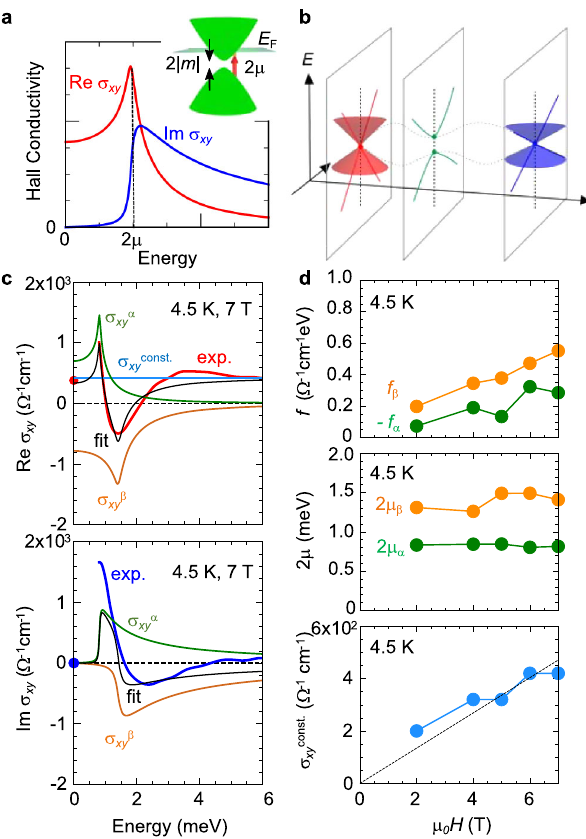
Fig. 3 Two-band model analysis for terahertz resonances. a The AH conductivity spectra calculated from the two-band model. (inset) The schematic illustration of the single anti-crossing point. b Schematic illustration of the electronic structure considered in the present analysis. c The red (Re σ xy ) and blue (Im σ xy ) curves show experimental results and the black curves represent the fi tting curves at 4.5 K and 7 T. The σ xy α (green) and σ xy β (orange) are optical Hall conductivity spectra arising from α - and β -bands, respectively. The constant term σ xy const. (light blue line) represents the lower-lying tail of the higher-energy resonances. The red and blue circles at zero frequency are the Hall conductivity acquired from transport measurement. d The magnetic- fi eld dependence of the fi tting parameters. f α , β , 2 μ α , β and σ xy const. are the spectral weights related to the anti-crossing gap m α , β , resonance energies and constant term, respectively. After we determine δ α = 0.06 meV and δ β = 0.53 meV using the data at 7 T, we use the same δ α and δ β for other magnetic fi elds. The dashed line in the lower panel represents the guide to the